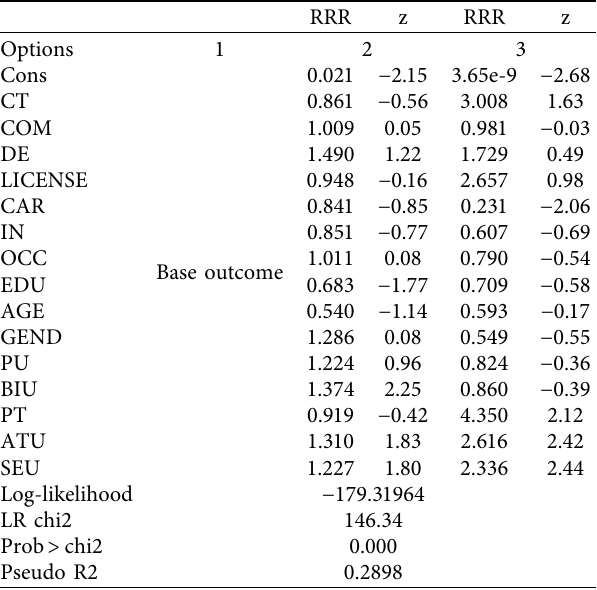
Table 8: Estimation results of the discrete choice model consid- ering latent variables.